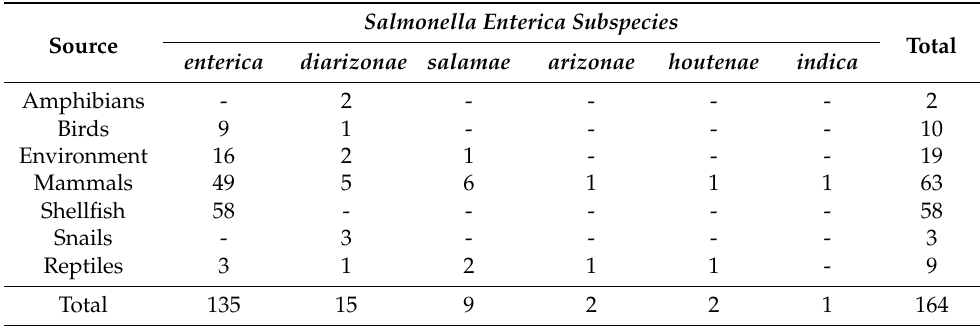
Table 1. Number and distribution of Salmonella subspecies detected from amphibians (frogs), birds, the environment, mammals, shellfish, reptiles and snails. Source